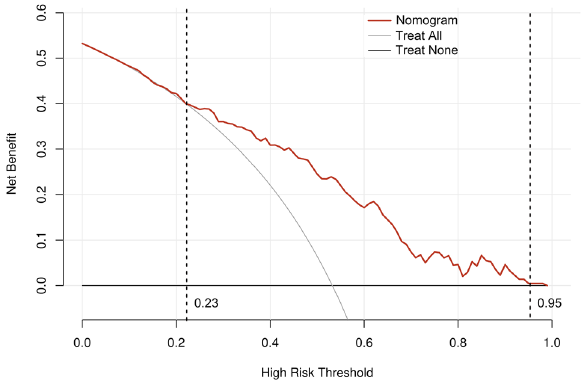
Figure 7. The decision-curve analysis (DCA) plot depicts the standardized net benefit of adopting the nomogram for predicting STR <